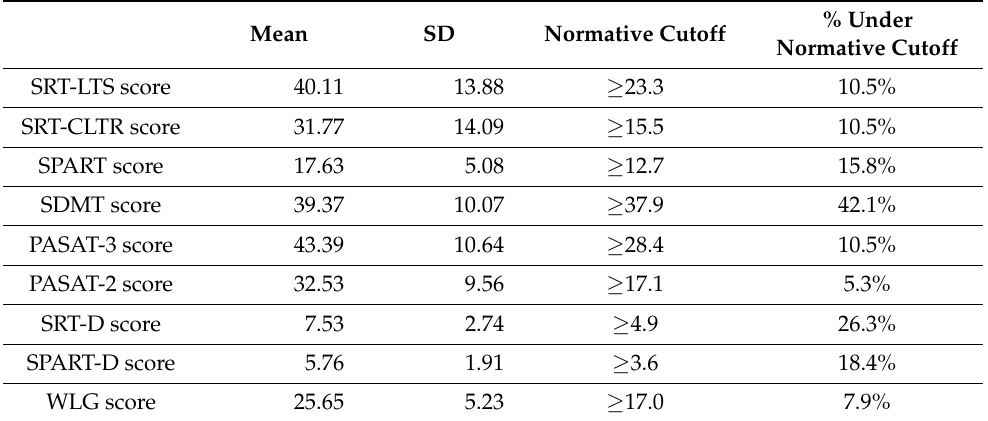
Table 2. BRB-NT subitem mean scores for the entire sample and normative